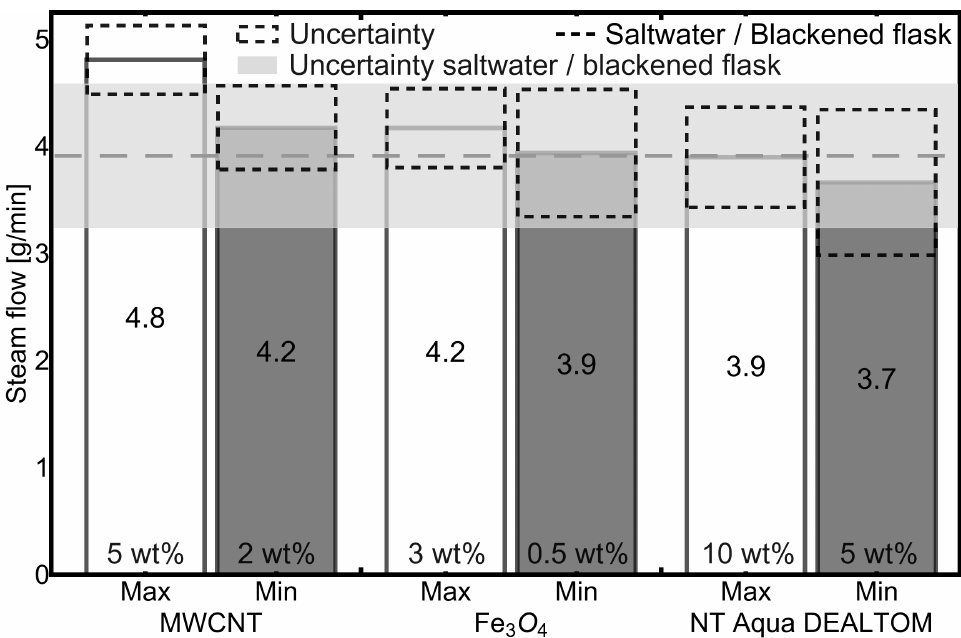
Figure 3. Maximum and minimum values of the mass flow of